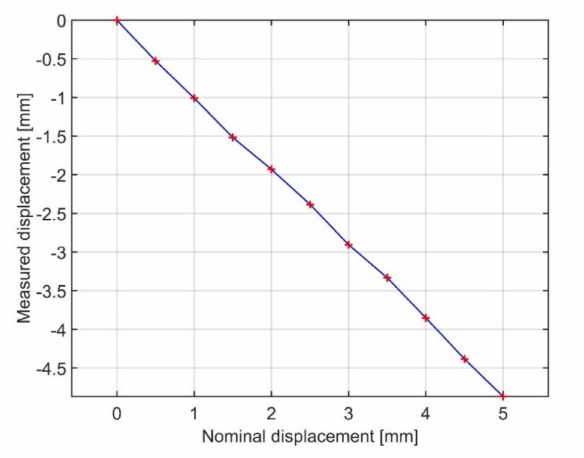
Figure 13. Displacement measured by GB-SAR in controlled